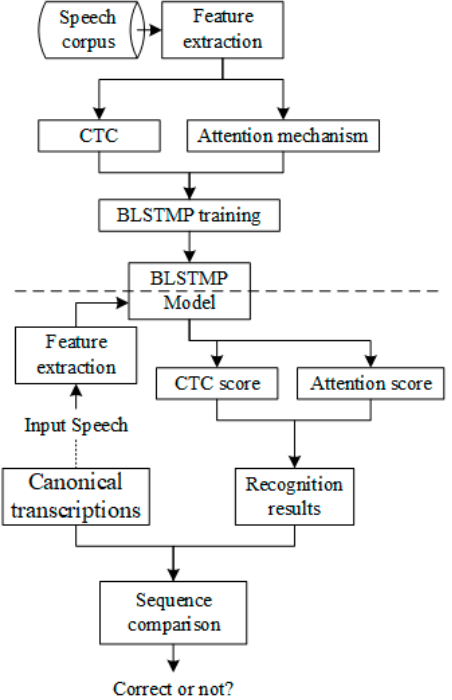
Figure 2. Block diagram of the end-to-end APED system based on hybrid connectionist temporal classification (CTC)/attention architecture.